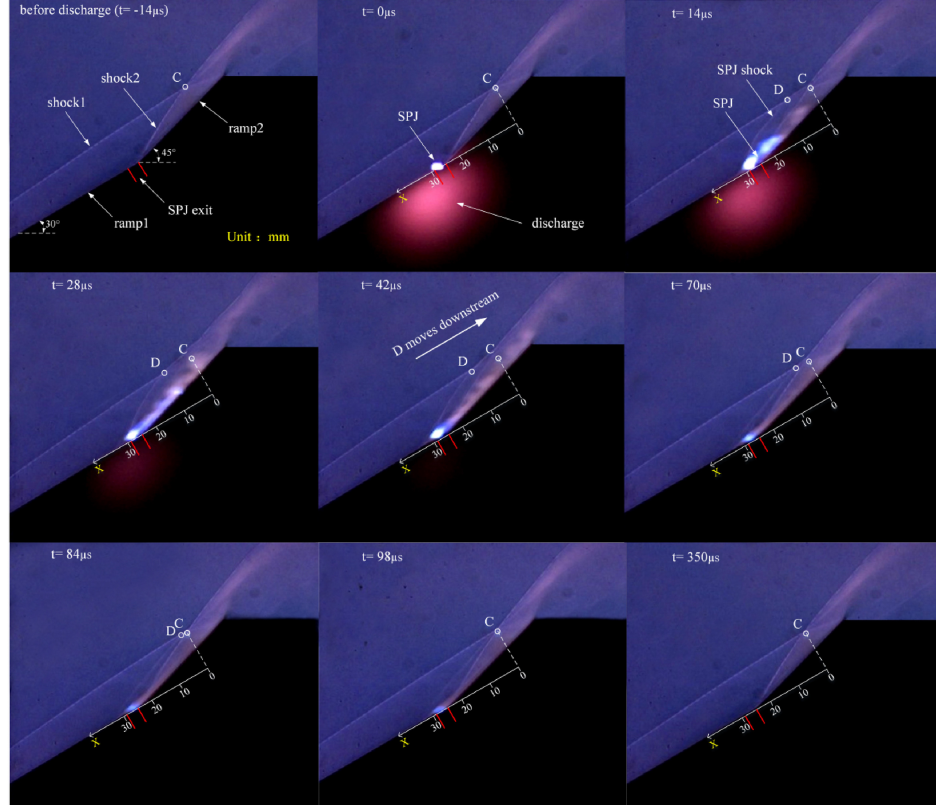
Figure 38. Change in flow structure of shock-shock interaction over a double ramp due to a SparkJet. Reprint from [69] with permission from